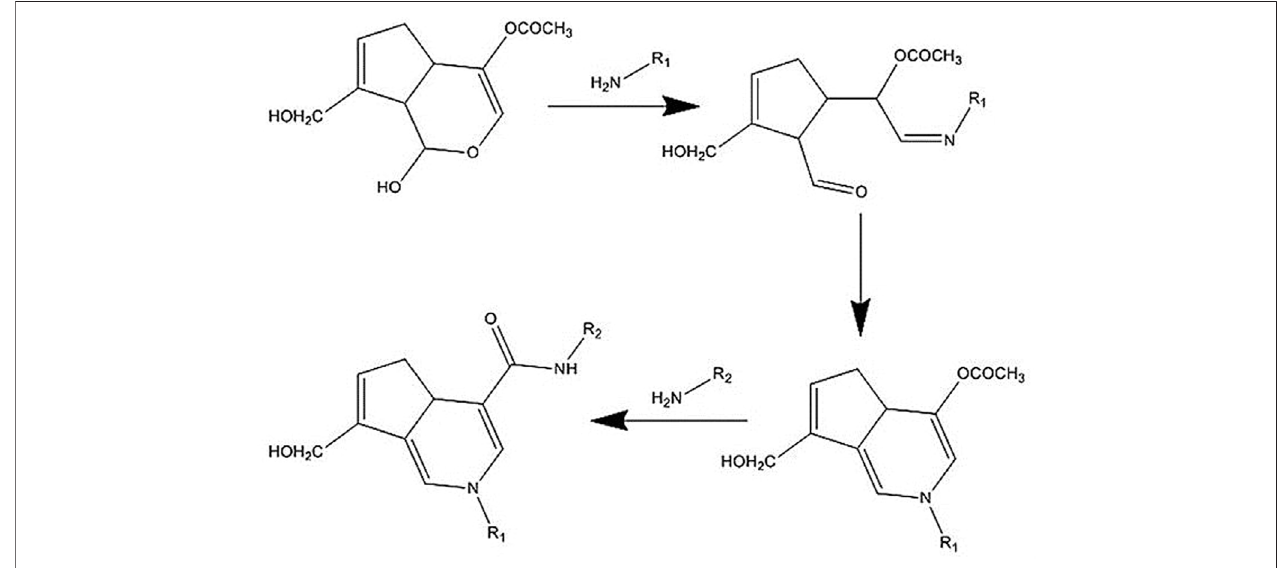
FIGURE 6| Mechanism of the crosslinking reaction. GNP will bind to the amine groups from polymer chains and then act as a polymer connector. The connection bridge between two polymer chains will lead to stability improvement.